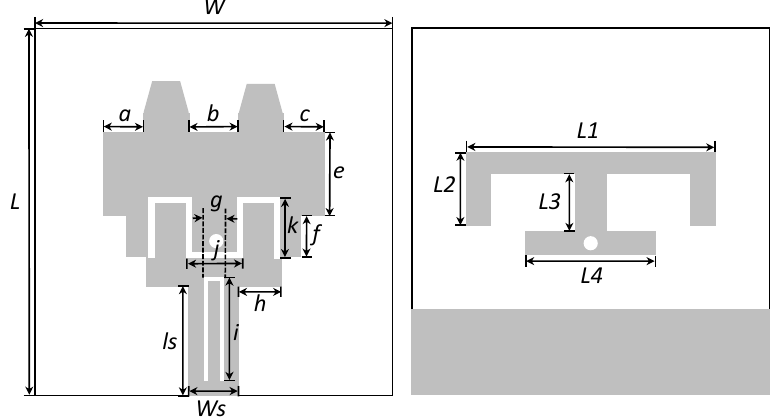
Figure 1. Labeled schematic of the proposed